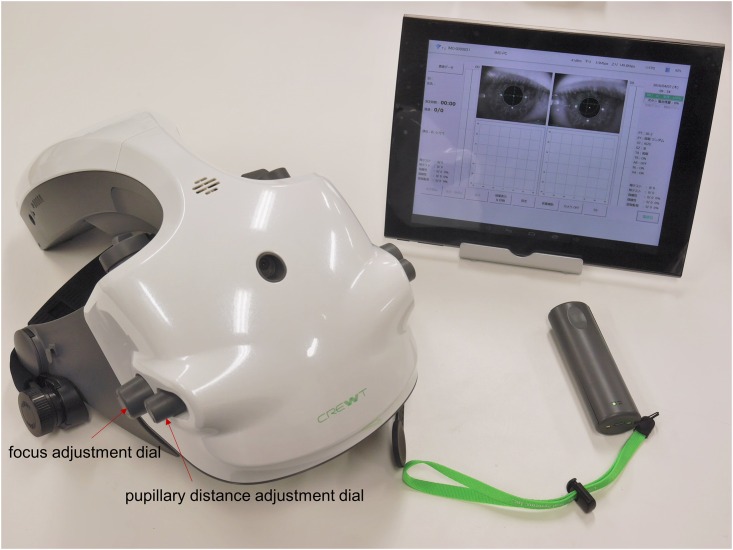
The head-mounted perimeter imo.The perimeter imo consists of a main perimeter unit, a user control tablet, and a patient response button.